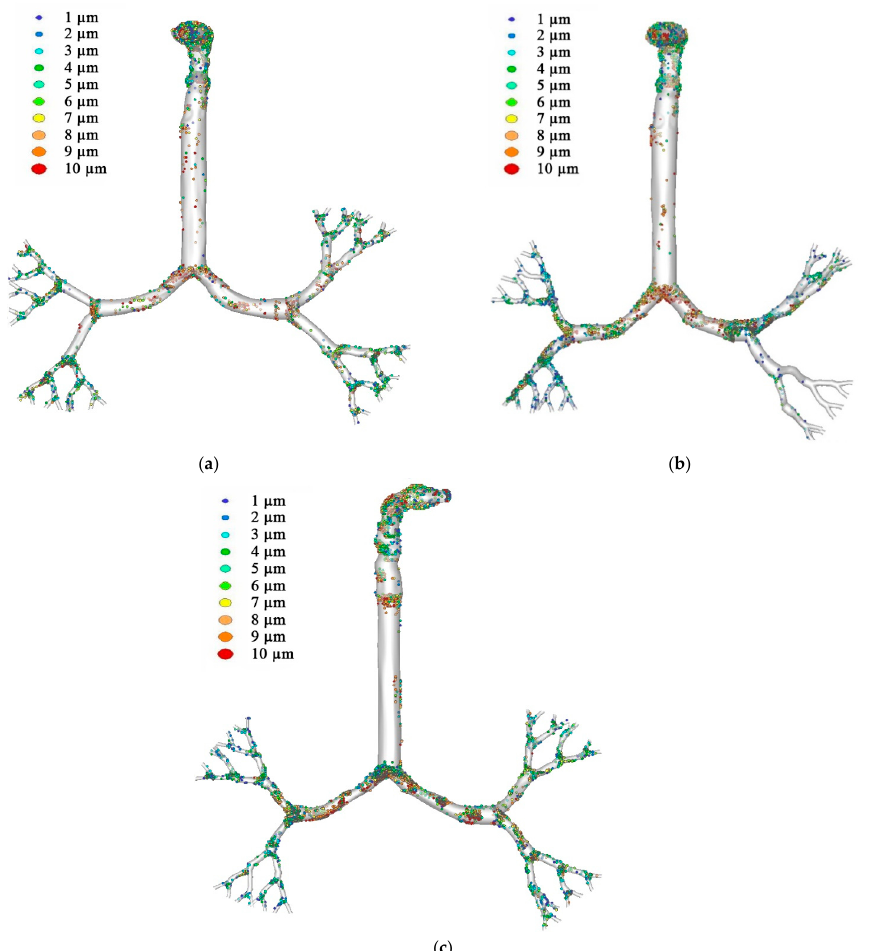
Figure 12. Aerosol deposition scenario at 60 L/min flow rate for ( a ) 50-year-old lung, ( b ) 60-year-old lung, and ( c ) 70-year- old lung. MT, mouth-throat; TR, trachea; G1, Generation 1; G2, Generation 2, G2R; G3 Generation 3; G4, Generation 4; and G5, Generation 5.